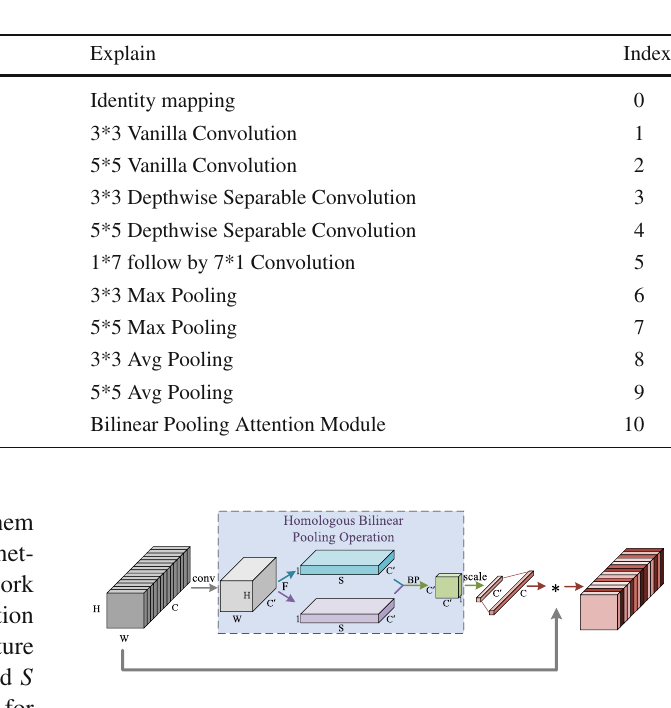
volution to scale channels of the input feature map, and then, the output feature map is flattened according to the dimension size. Note that the bilinear pooling operation is performed on the same pixel location of the channel. The extracted feature map is used for multi-layer scaling to obtain the weight vec- tor with the same dimension to the original feature map, and the weight vector reflects the interaction among all